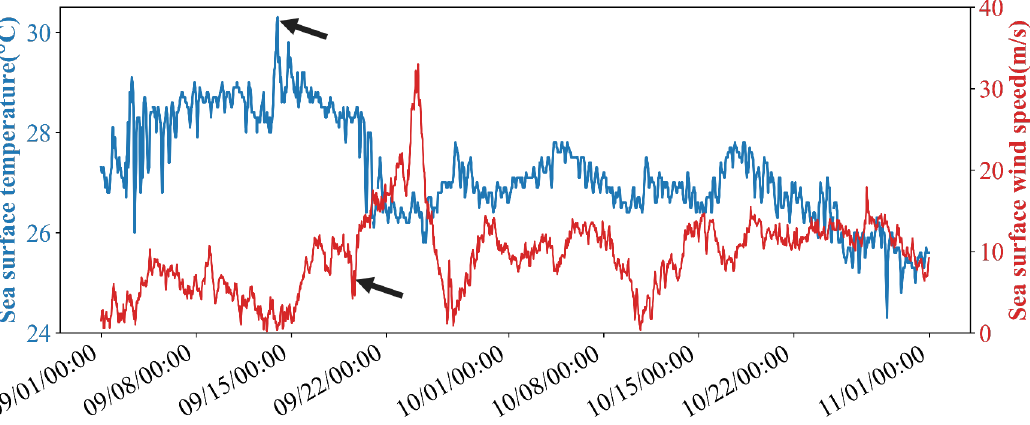
Figure 7. Temporal sea surface temperature and wind speed from no. QF206. The temperature dropped from 30.4 °C to 25.8 °C between 09:00 13 September and 06:30 22 September. The “typhoon cooling effect” is indicated by the black arrow.